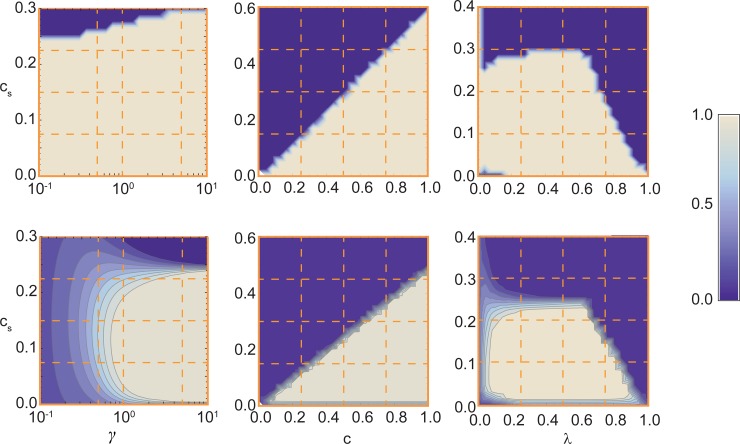
Evolutionary robustness and Prevalence of signaling strategy (10|01).The top contour plots indicate the regions of model parameters in which the signaling strategy (10|01) is Evolutionary Robust (ERS) (bright areas). To this end we vary the selection pressure γ and the cost of signaling c
S (left panel); the cost of cooperation c and c
S (center panel) and the probability that Nature chooses α (λ) and c
S. The bottom panels show, for the same parameter space, the prevalence of the population in a configuration in which all individuals adopt the signaling strategy (10|01). The remaining parameters (and also those plotted whenever not varied) are Z = 100, N = 9, M = 5, c = 0.5, γ = 5, F = 10, λ = 0.5. A signaling system emerges for a wide range of values of the model parameters. Comparison of top and bottom panels shows the existence of parameter regions in which (10|01) is an ERS and yet the population almost never adopts this strategy and, conversely, there are regions in which (10|01) is not an ERS and yet the population spends approximately 30% of its time in configuration comprising only this strategy (see main text for details). Note, in particular, that signaling systems emerge more robustly under strong selection, a scenario that is very likely to occur in many cases under α conditions (those that entail a public good). Moreover, for some species the enhancement factor F = 10 possibly constitutes an underestimate given that, under α, survival may be at stake (as is the case in, e.g., many bacterial species), and successful cooperation likely leads to higher benefits. Nonetheless, a signaling system emerges for a wide range of values of λ, provided that c
S
< c/2.